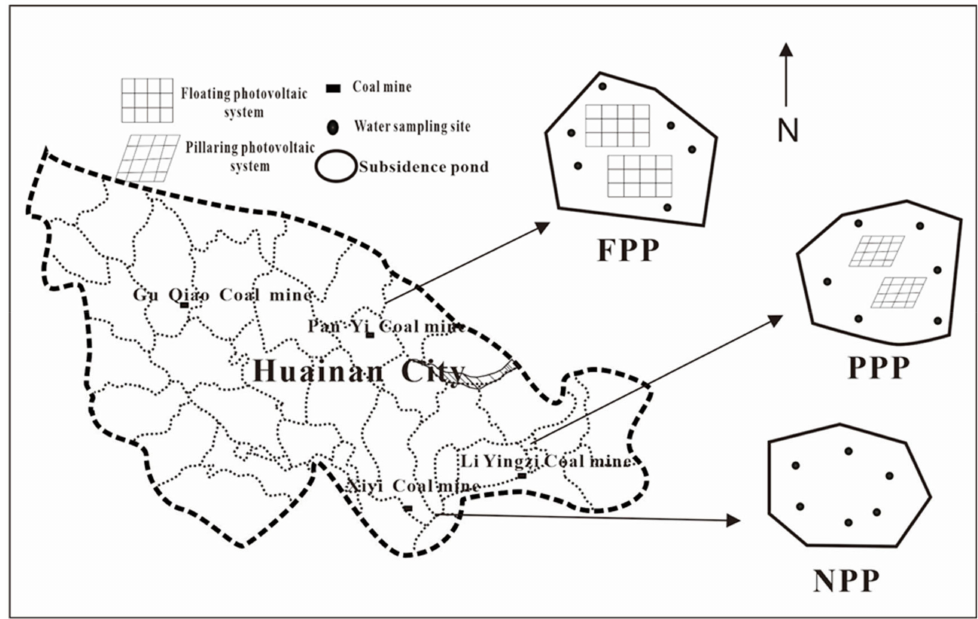
Figure 2. Study area and water sampling sites in different subsidence ponds in Huainan